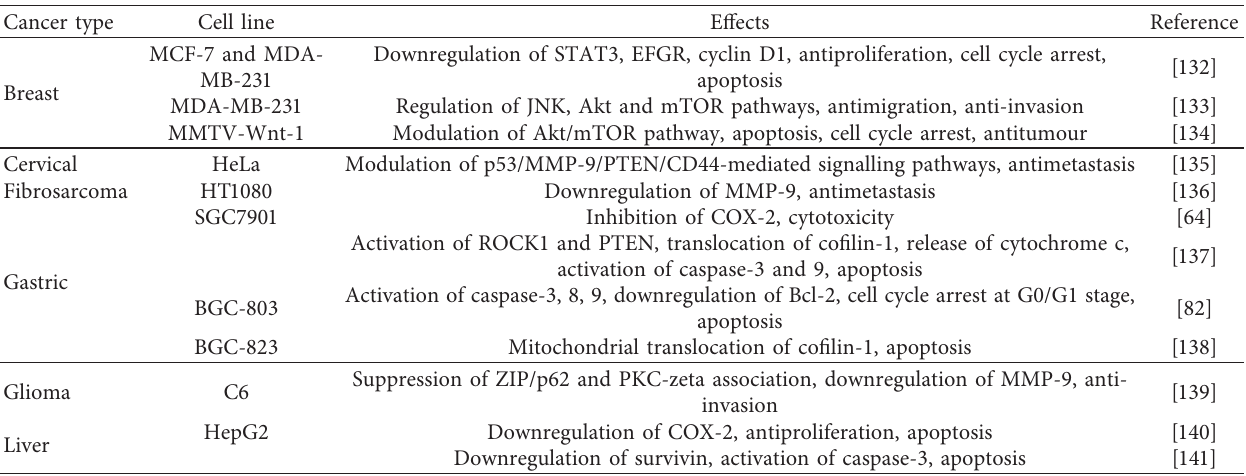
Table 6: The anticancer effects of ursolic acid on different cell